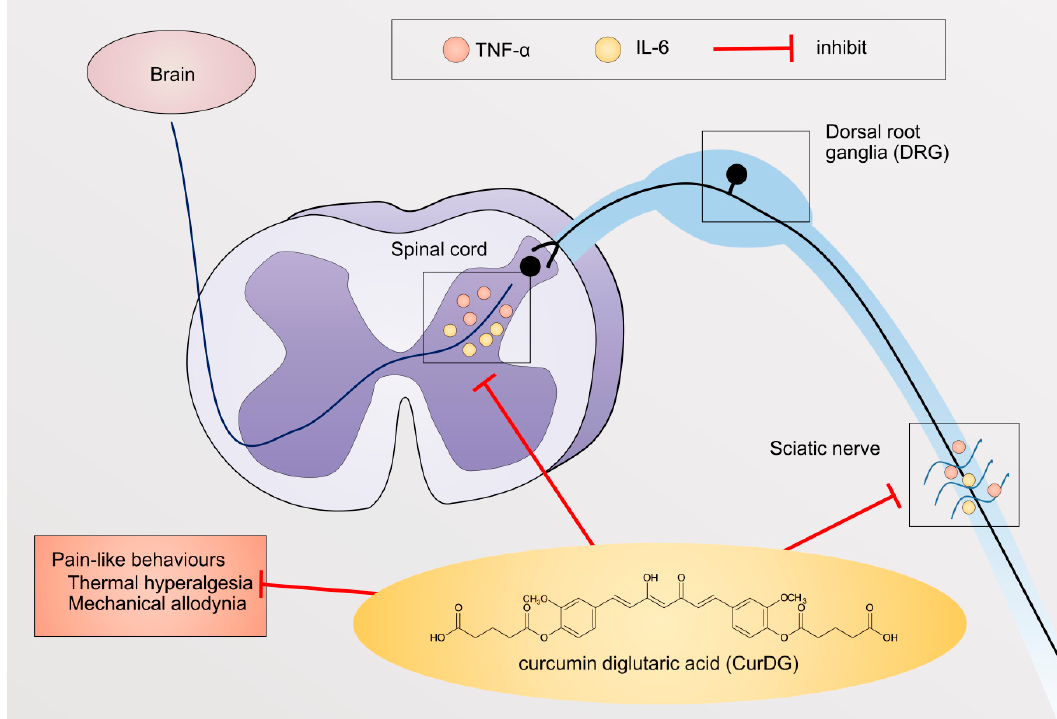
Figure 6. Systematic mechanism of action of CurDG. CurDG inhibits the expression of TNF ‐α and IL ‐ 6 in the sciatic nerve and spinal cord of the CCI ‐ mice, as well as suppresses pain ‐ like behaviors: thermal hyperalgesia and mechanical allodynia.